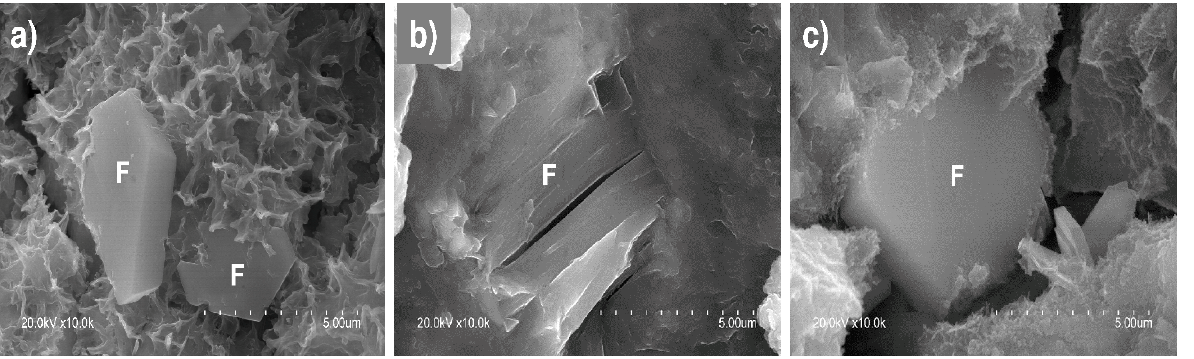
are the sites where ettringite normally crystallises.